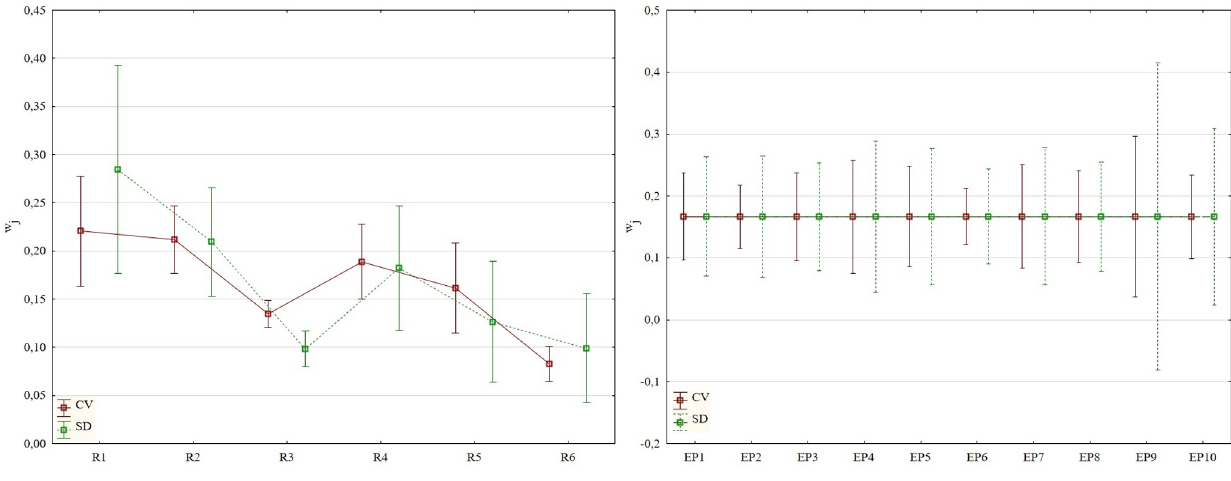
Fig 3. Average importance of the assessed criteria (whisker: max—min).